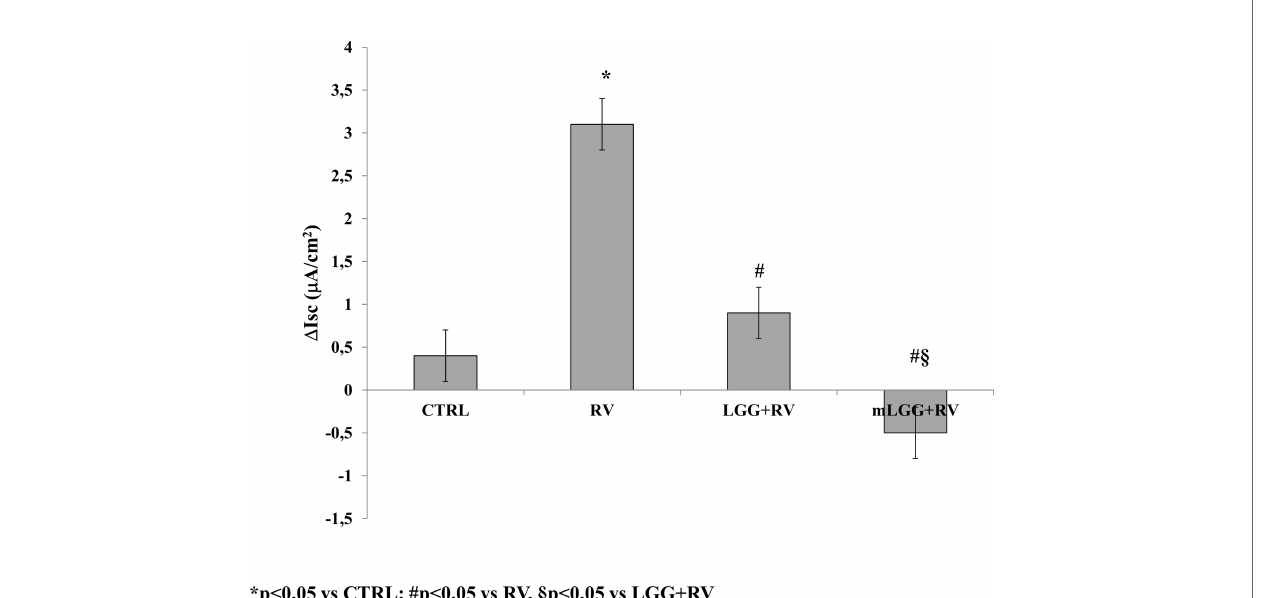
FIGURE 1 | Effects of LGG on enterotoxic effect induced by RV. Caco-2 cell monolayers were infected with RV and preincubated with LGG or mLGG as described in the Methods and then, the short-circuit current ( I sc) was evaluated in Ussing chambers togheter with unifected cells (CTRL). *p < 0.05 vs CTRL; # p < 0.05 vs RV; § p < 0.05 vs